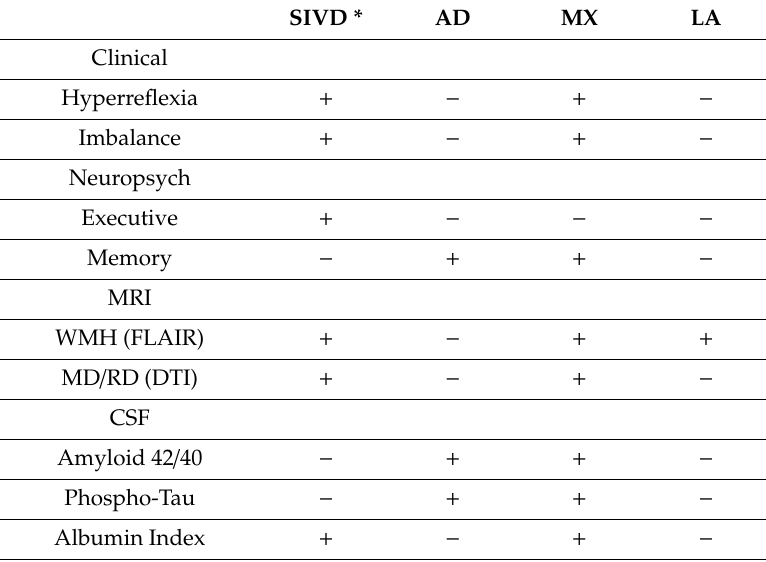
Table 1. Biomarker Features used to make Diagnoses.